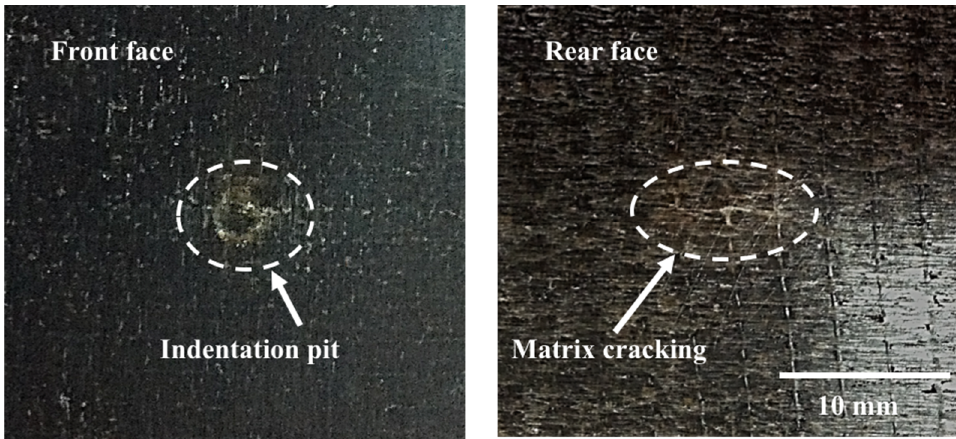
Figure 2. ( a ) Impact load–time curve and ( b ) impact load–displacement curve of flax fiber reinforced epoxy plastic (FFRP) following incident energies of 1, 3, 5, and 6 joules.